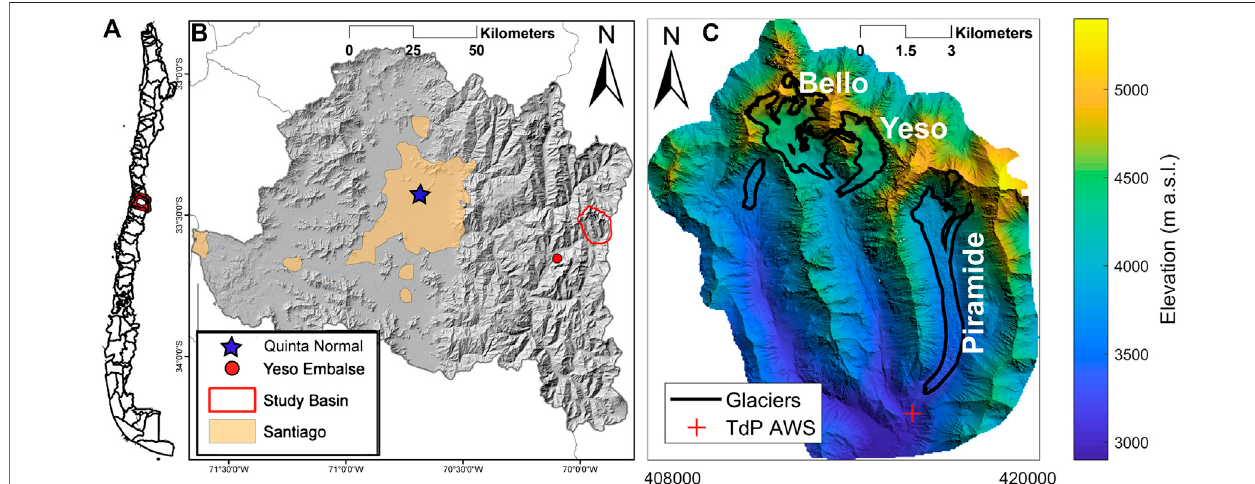
FIGURE 1 | A map of (A) Chile, (B) the metropolitan region and (C) the Rio Yeso catchment. The automatic weather station Quinta Normal, Yeso Embalse and Termas del Plomo are marked in panels b and c. The hillshade in b is provided by ASTER GDEM and the hillshade/digital elevation model scale in c is that of SnowOFF_2018. Glacier outlines were manually digitised from the Pléiades SnowOFF_2018 orthoimage.